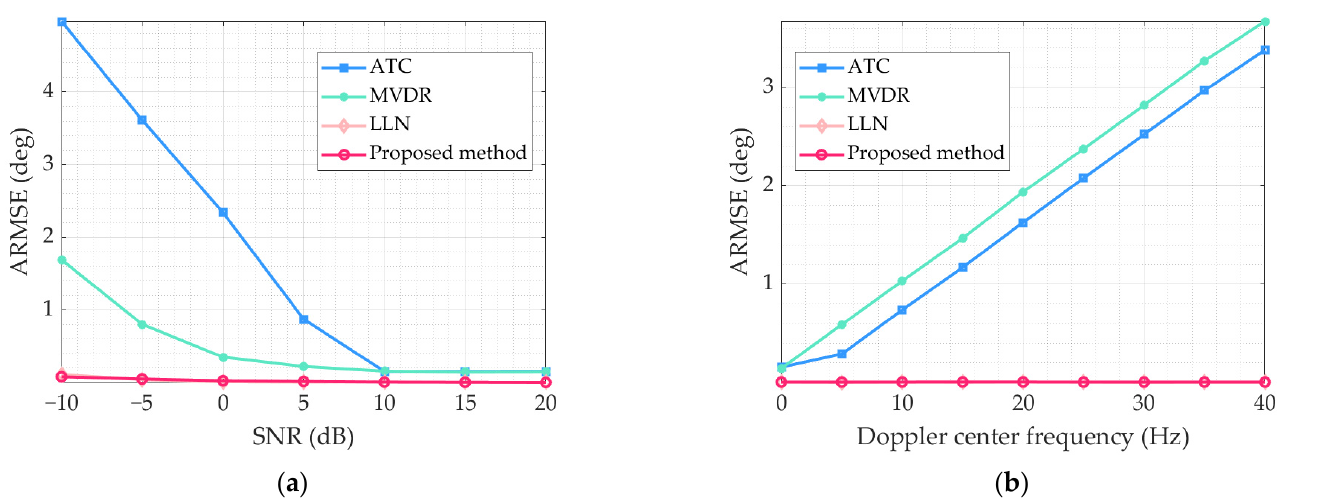
Figure 10. Comparison of stability of different estimation methods. ( a ) ARMSE of the phase error versus SNR. ( b ) ARMSE of the phase error versus Doppler center frequency.